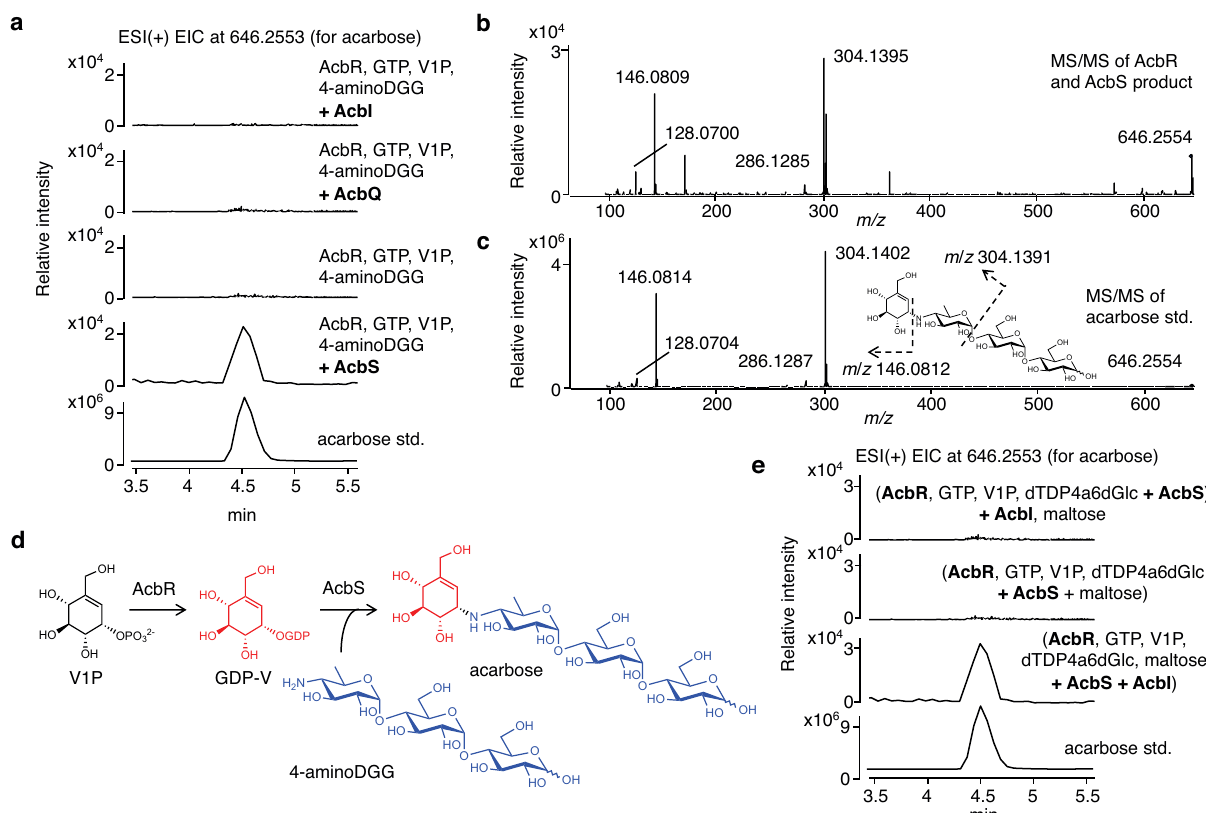
Fig. 4 Characterization of the pseudoglycosyltransferase AcbS. a ESI( + ) EIC for acarbose at m/z 646.2553 of reaction mixtures with AcbI, AcbQ, or with or without AcbS; b ESI-MS/MS of the AcbS product; c ESI-MS/MS of acarbose standard; d reaction scheme of AcbR and AcbS; e ESI( + ) EIC for acarbose at m/z 646.2553 of reaction mixtures with AcbI, AcbR, and AcbS added in different sequence and combination (see text and experimental section). All experiments were carried out at least three times with similar results. ESI, electrospray ionization mass spectrometry; EIC, extracted